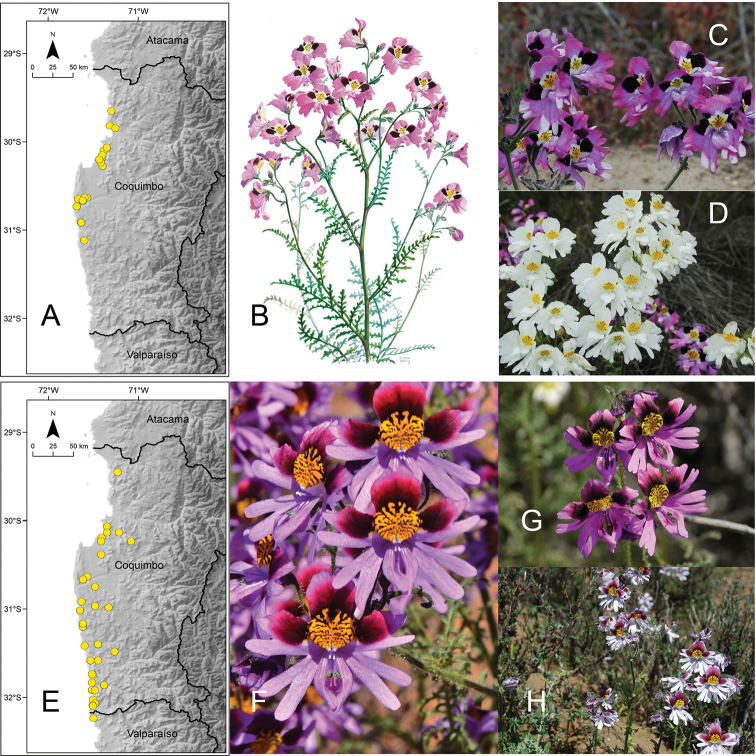
A distribution of Schizanthus
carlomunozii
var.
carlomunoziiB illustration of S.
carlomunozii
var.
carlomunozii by S. Rafols (Muñoz-Pizarro 1966) C, D examples of S.
carlomunozii
var.
carlomunozii in Fray Jorge National Park E distribution of Schizanthus
carlomunozii
var.
dilutimaculatusF examples of S.
carlomunozii var. dilutimaculatus in Amolanas G Las Majadas H El Ñague. Photos by M.T. Eyzaguirre (C, D, G, H), M. Aldunate (F).